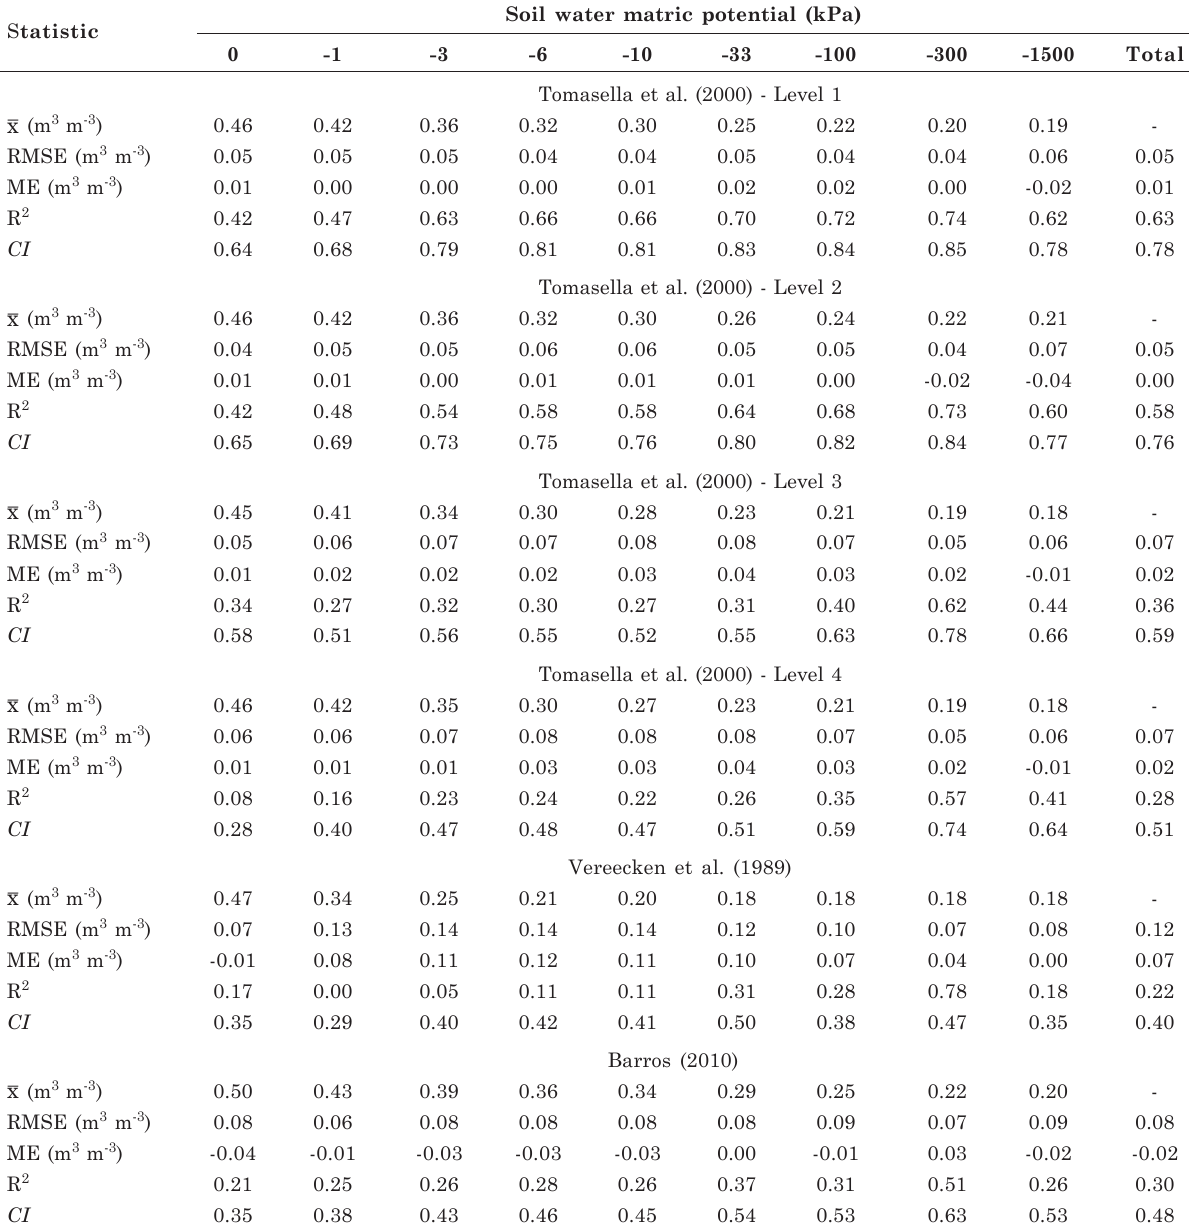
x – : mean of the estimated values (m 3 m -3 ); RMSE: root mean square error; ME: mean error; R 2 : coefficient determination; CI : Confidence Index proposed by Camargo & Sentelhas